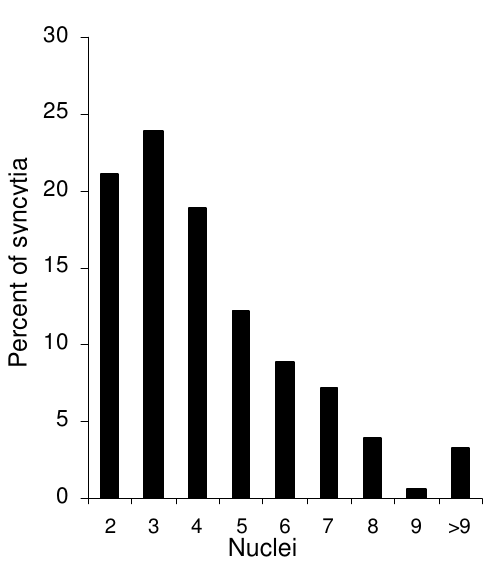
FIGURE 9. (A) Number of nuclei in syncytia formed in cocultures of DiI-CD4 + and DiO-Env + cells. Nuclei were stained with the Hoechst 33342 dye and counted in 180 triple-fluorescent cells. (Reprinted from Huerta et al.[87]. Copyright 2006, with permission from